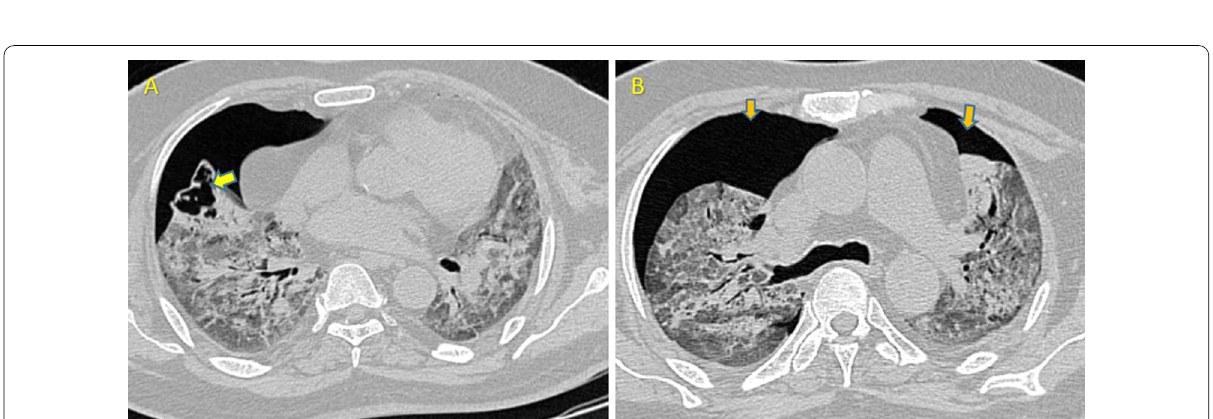
Fig. 5 Axial HRCT scans showing imaging features of Candidiasis in case 5 of COVID-19. A Axial HRCT thorax of case 5 shows small cavitary lesions with few internal septations and tiny soft tissue nodular opacities within (yellow arrow in A ). Sputum culture revealed Candida species. B Bilateral pneumothorax can be seen (orange arrows in B